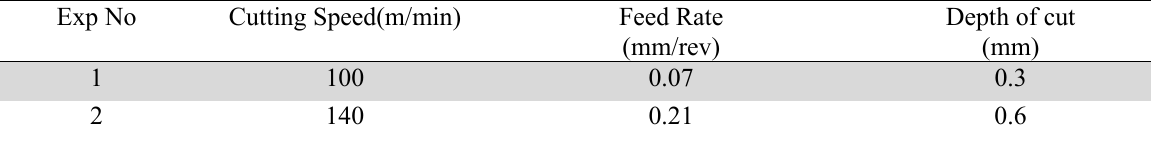
Parameters used in the confirmation test for tool wear Exp